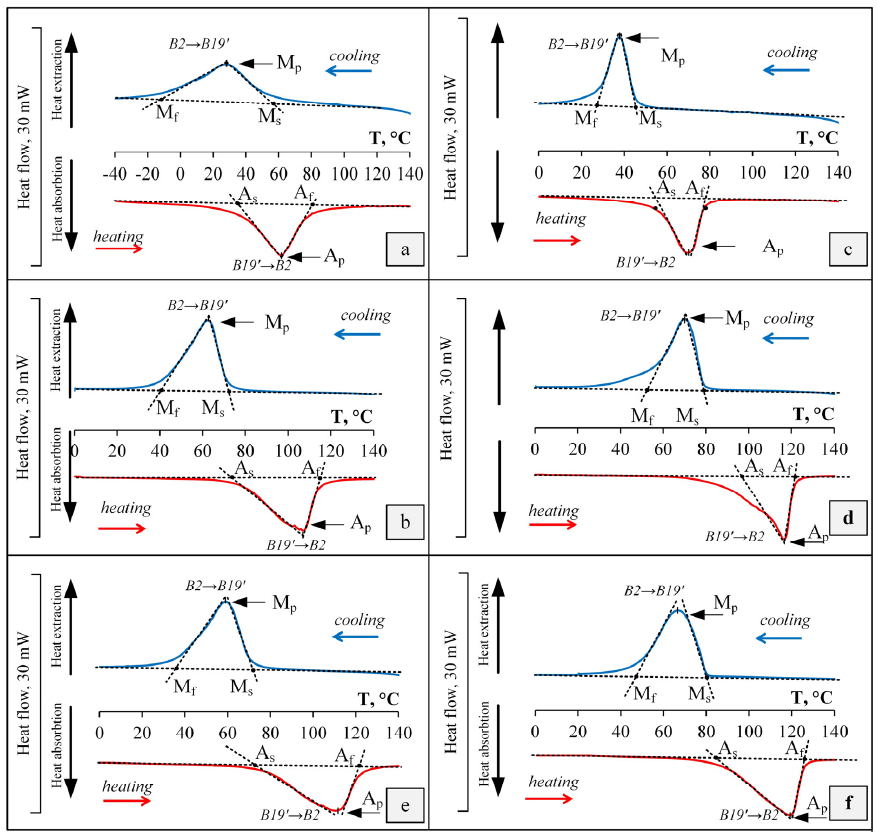
Figure 7. Calorimetric curves of the TiNiHf initial ingots in as-cast state and after annealing at 1000 °C for 1 h: 1.5 at.% Hf—( a , c ), 3.0 at.% Hf—( b , d ), and 5.0 at.% Hf—( e , f ).